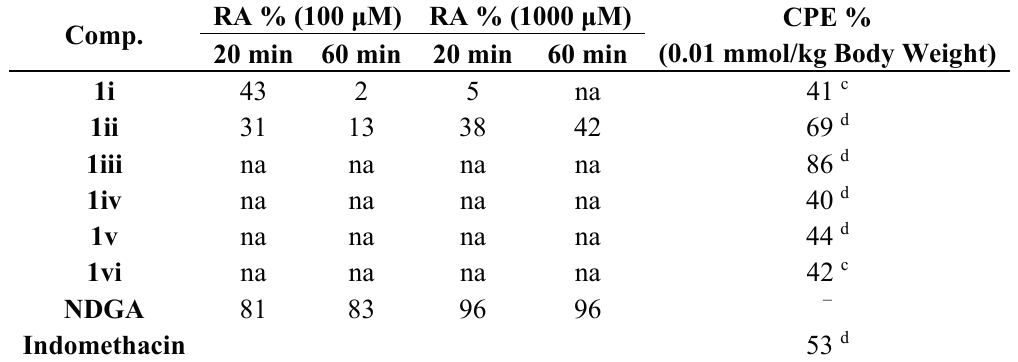
Table 5. Reducing ability measured as the interaction with DPPH (reducing activity % (RA %)); inhibition of rat paw edema induced by carrageenan (CPE %). Comp.